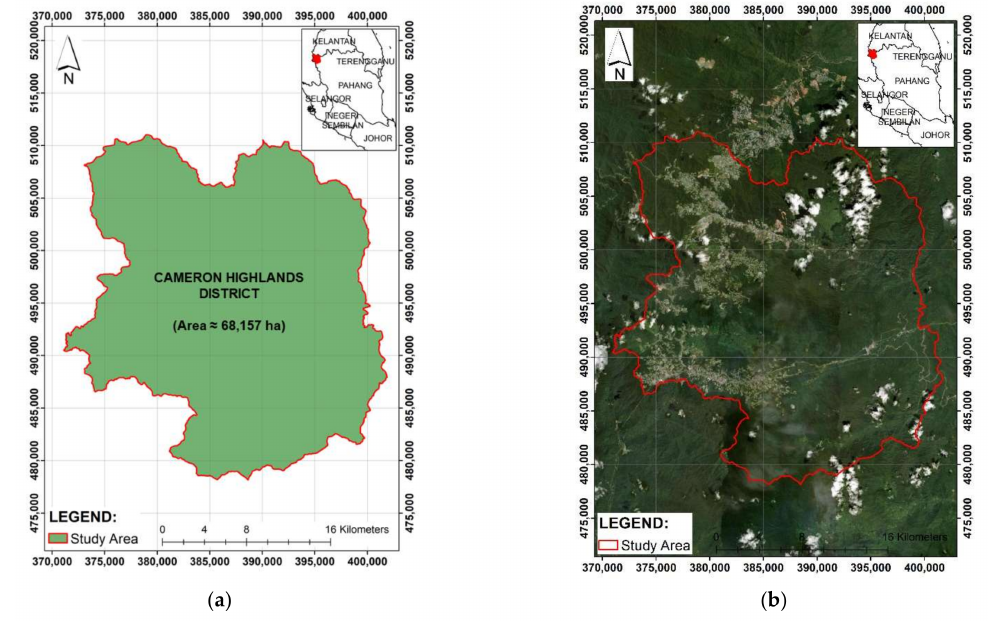
Figure 1. ( a ) District of Cameron Highlands as the study area (adapted from Ref. [21]), ( b ) view of the study area from Google Earth